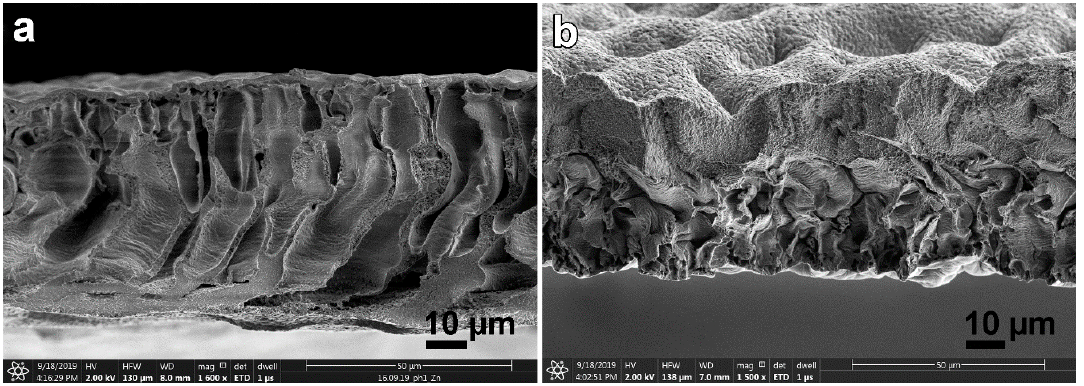
Figure 17. SEM microphotographs of the cross section of dried cellulose films, after coagulation in the IPA at temperature of 80 °C: washing with alcohol and dried ( a ); and washing with water and dried ( b ). Microphotographs of the cross sections of cellulose films formed in a “hot” coagulant fully reflect the processes occurring during the di ff usion interaction of components detected by